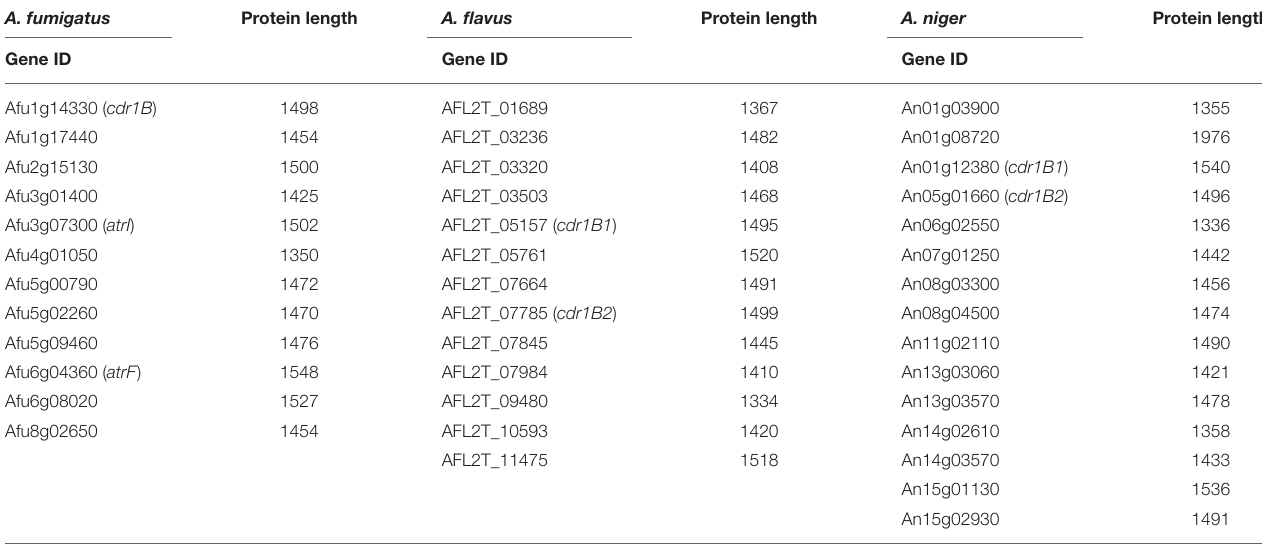
TABLE 5 | List of the PDR-type ABC transporter